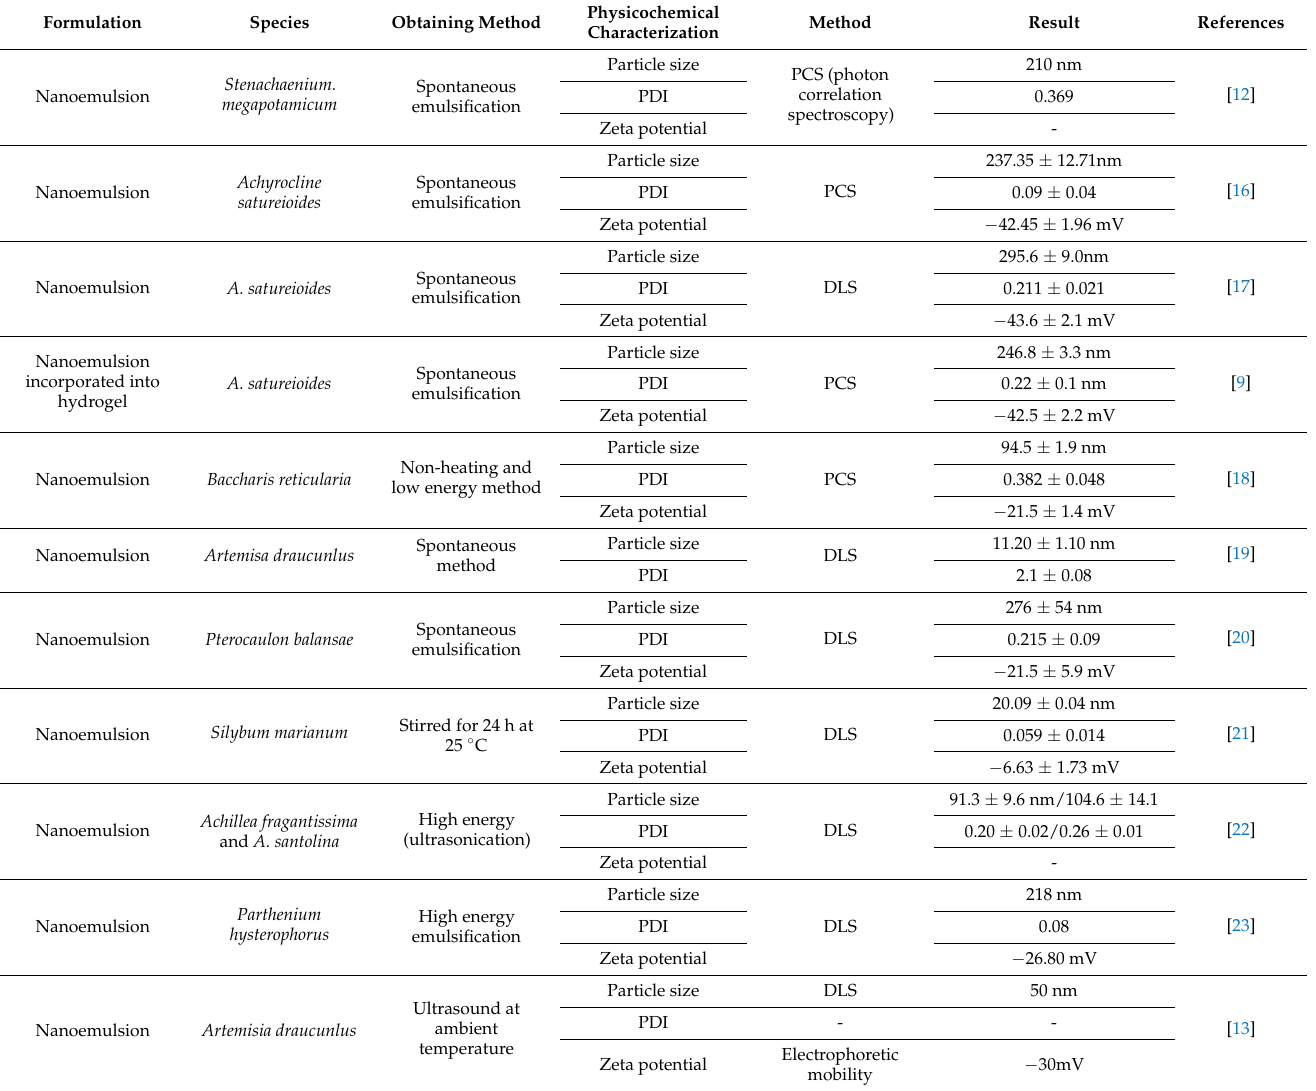
Table 5. Physicochemical characteristics of